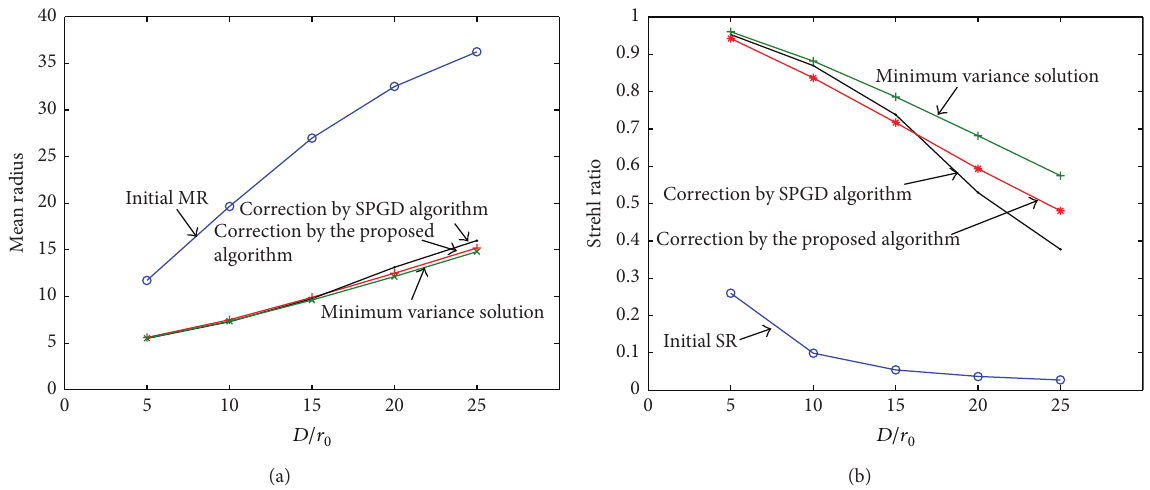
Figure 6: Comparisons of MR of initial, correction by SPGD algorithm, correction by proposed algorithm, and the minimum variance solution (a) and comparisons of SR (b) under different